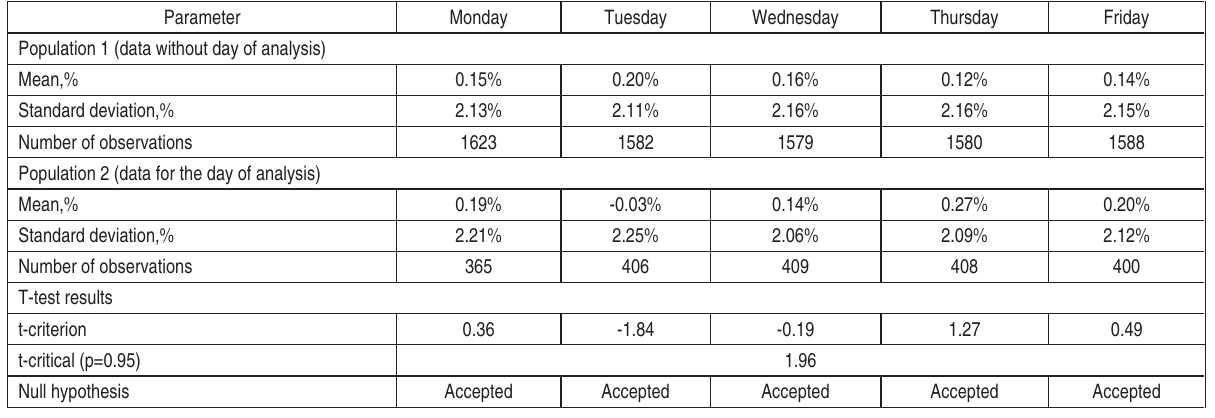
Table B1. T-test of the day-of-the-week effect for PFTS index